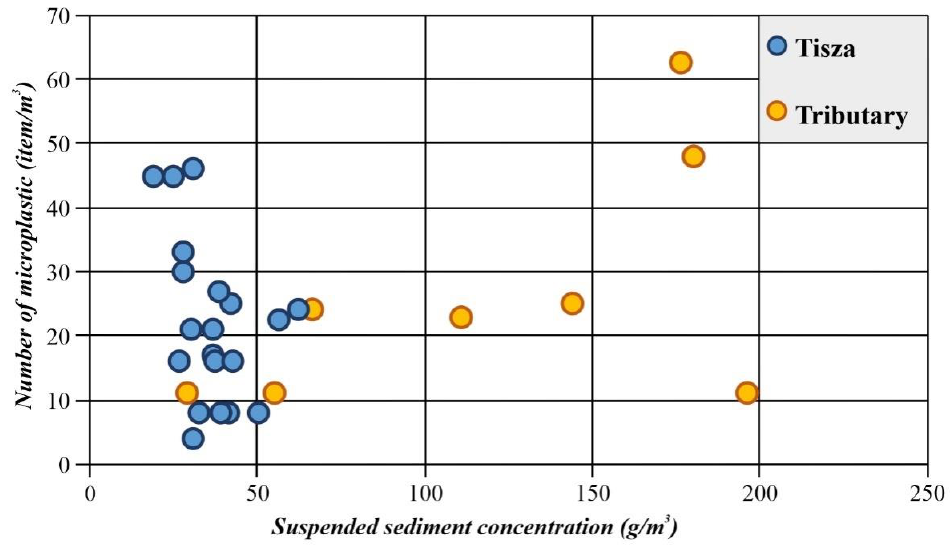
Figure 6. Correlation between suspended sediment concentration and transported microplastics= during the low stage.